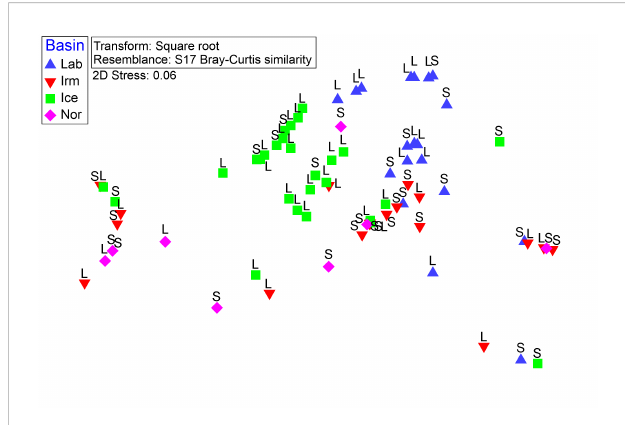
FIGURE 9 Non-metric Multidimensional Scaling (nMDS) of Benthosema glaciale diet. Prey weight as input (expressed as the ratio between prey weight and predator weight). Symbols represent the basins (Lab=Labrador Sea, Irm=Irminger Sea, Ice=Iceland Sea, and Nor=Norwegian Sea) where S and L are fi sh length groups (S=small fi sh and L= large fi sh, SL< 50 mm and SL ≥ 50 mm respectively).